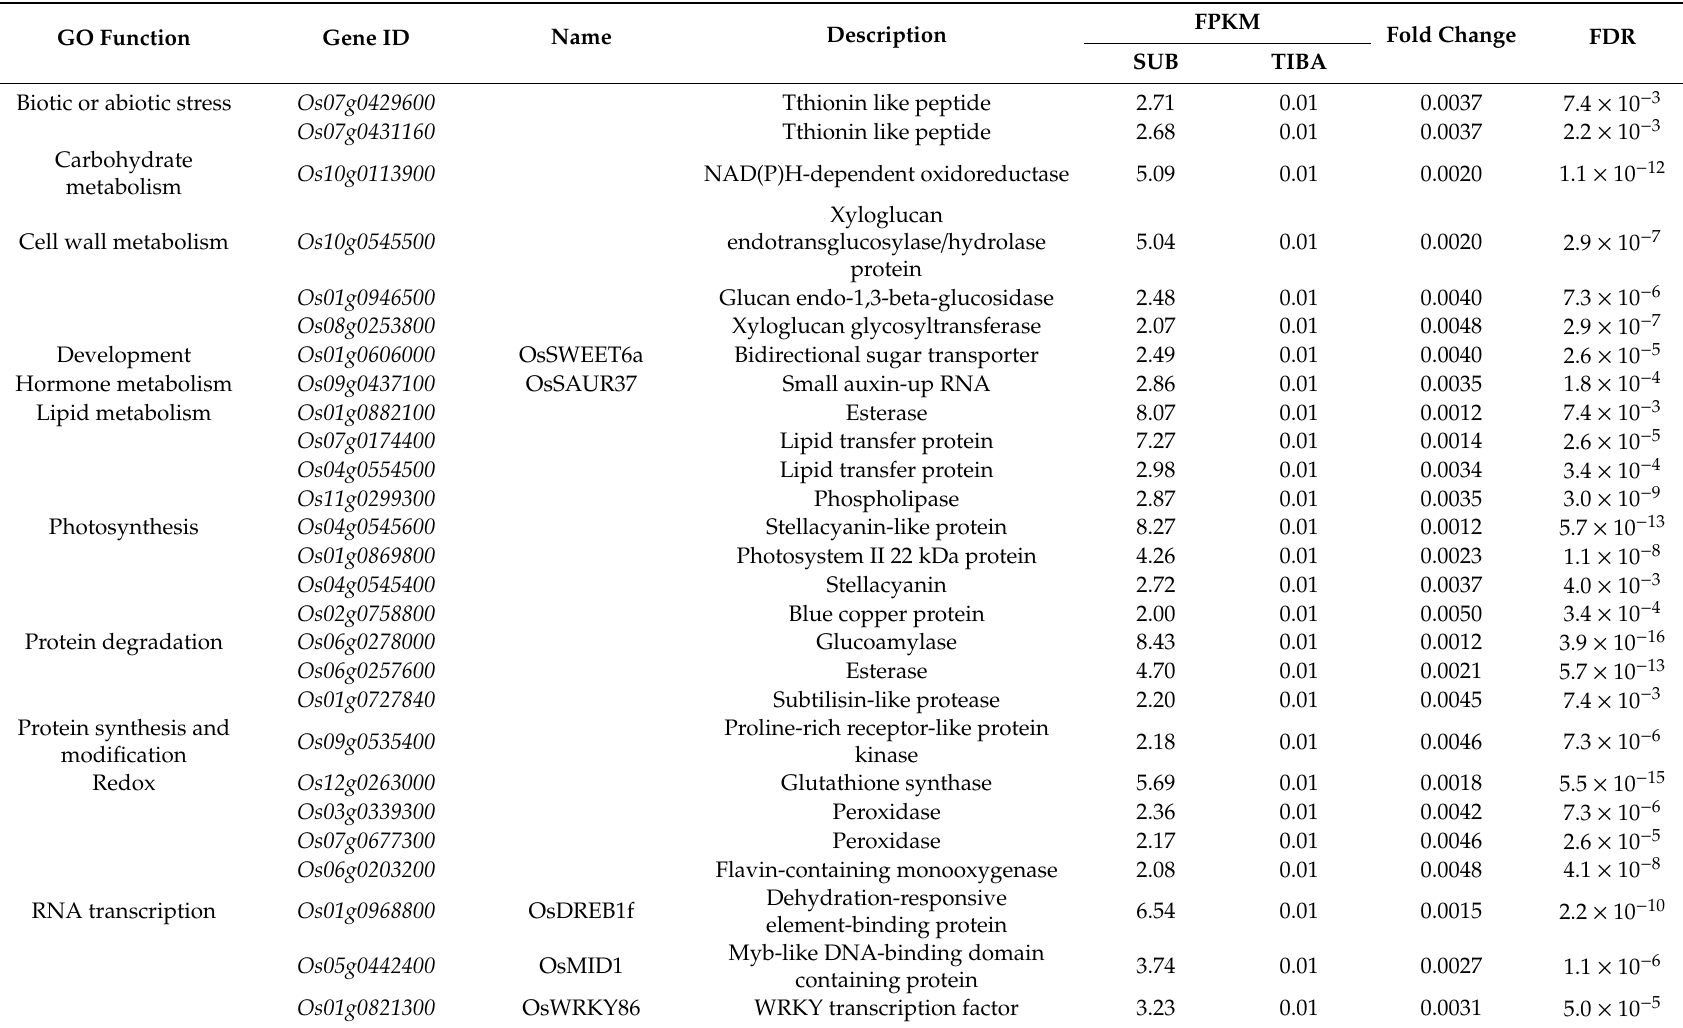
Table 2. The di ff erentially expressed gene was significantly downregulation between submergence (SUB) and submergence with 10 µ M TIBA (SUB + TIBA) in